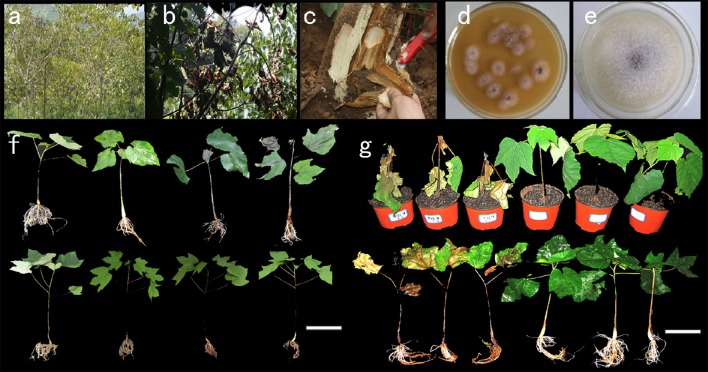
Tung wilt pathogen isolation and pathogenicity testing in V. fordii and V. montana. (A) A tung forest attacked by wilt disease; (B) a V. fordii tree with Fusarium disease; (C) a longitudinal section of a V. fordii tree with wilt disease; (D) isolation of pathogens from the wilt-diseased tung tree; (E) a further pure culture of the potential fungal pathogen; (F) seedlings of V. fordii and V. montana infected with the tung wilt pathogen F. oxysporum at different stages: the upper row shows V. fordii seedlings, and the lower row shows V. montana seedlings; (G) seedlings of V. fordii and V. montana severely infected with F. oxysporum. Scale bar = 10 cm.